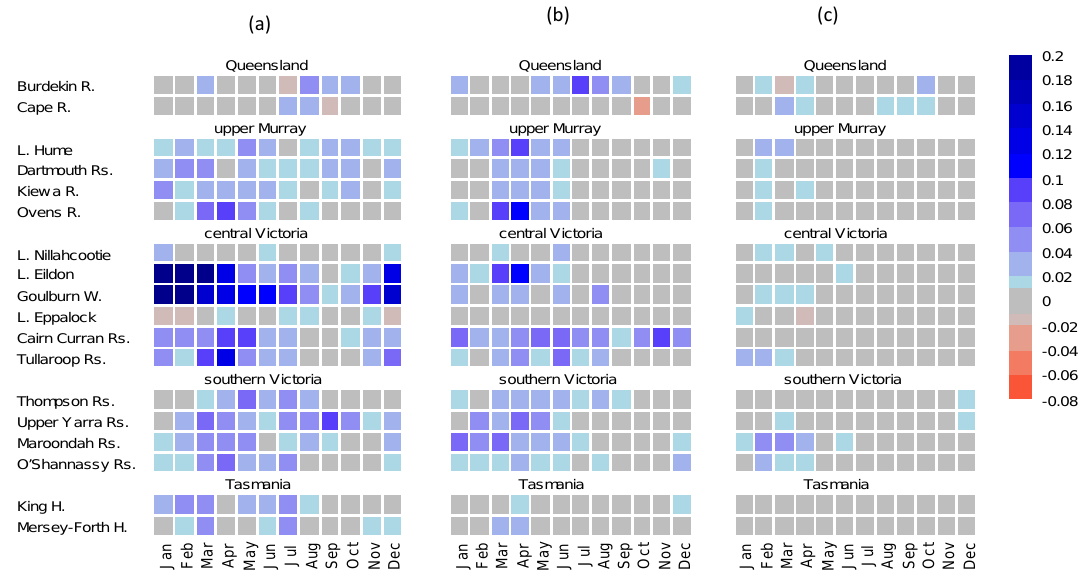
Fig. 4. (a) Difference in RMSEP values between WAPABA predictions and method A (WAPABA – method A); (b) difference in RMSEP values between method A and B (method A –method B); (c) difference in RMSEP values between method B and C (method B – method C).